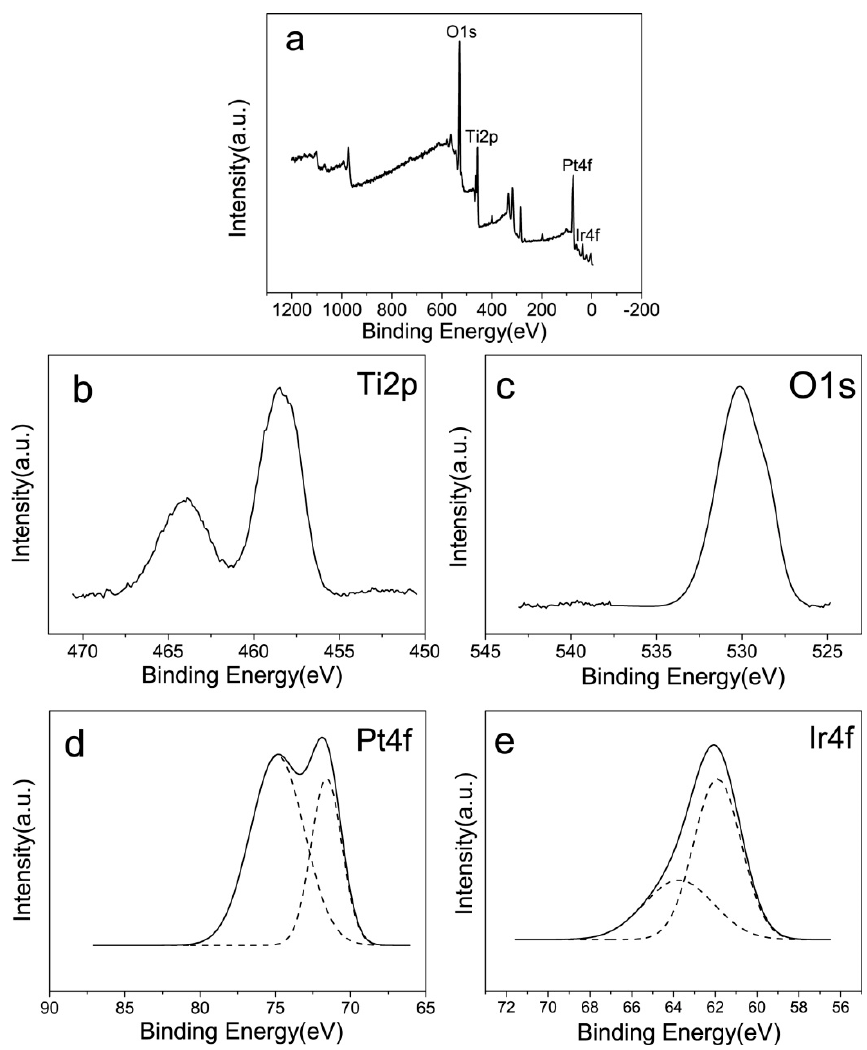
Figure 3. ( a ) XPS spectra of Pt-IrO 2 /TiO 2 NTs/Ti, ( b ) Ti2p, ( c ) O1s, ( d ) Pt4f; ( e ) Ir4f.